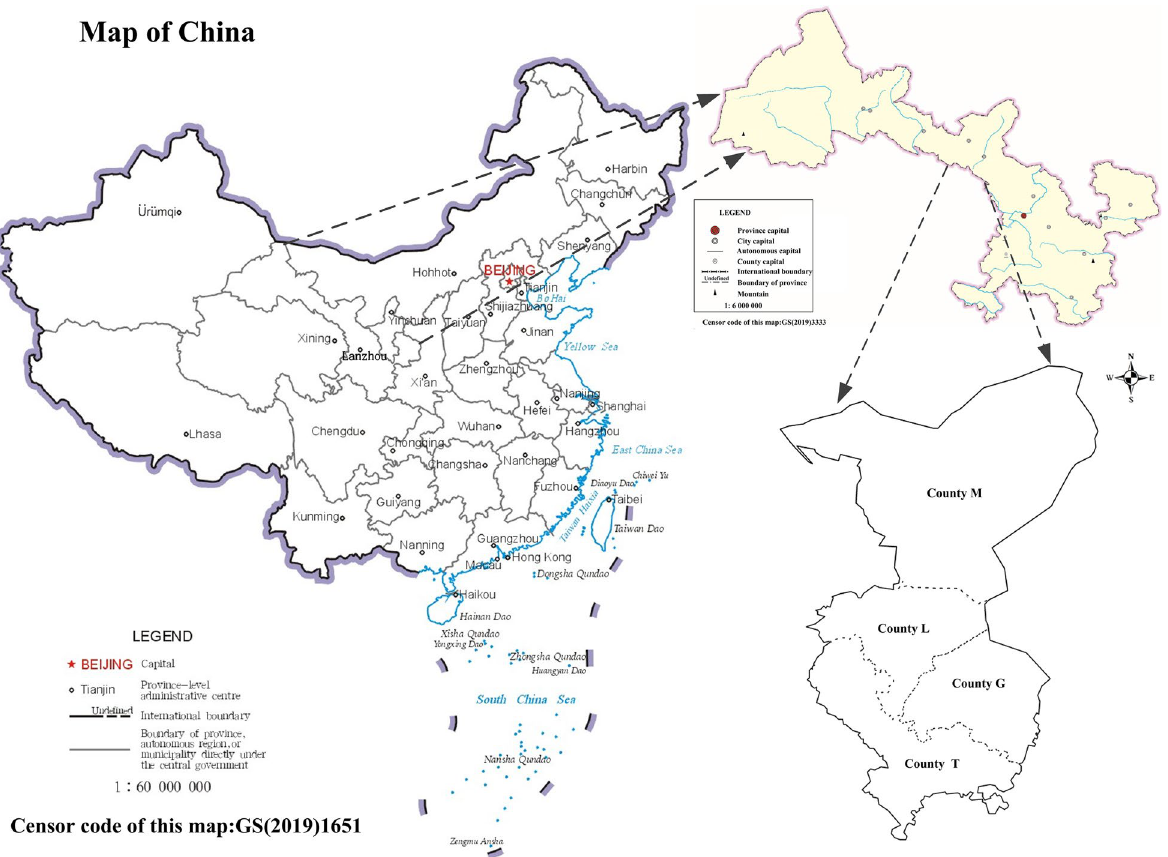
Fig. 7 Study area and approximate loci for this study